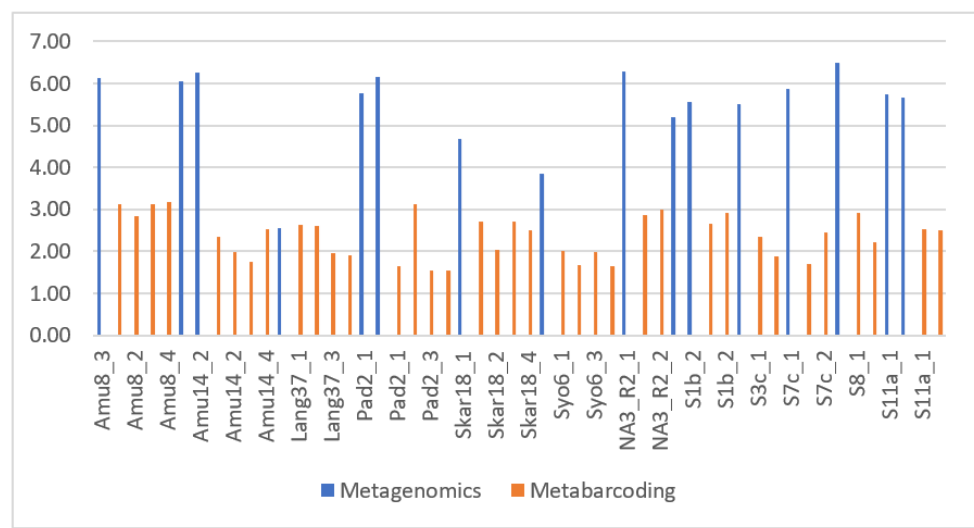
Figure 1. Shannon indices for all analyzed samples. Samples to the left—Amu8 to Syo6—are from East Antarctica, whereas samples to the right—NA3_R2 to S11a—are from Svalbard (the Arctic). The difference between the Shannon indices of the metagenomic and metabarcoding data sets was due to a higher number of OTUs recognized by the Kraken 2 software in the metagenomic datasets. Many OTUs could not be found at all in the metabarcoding data sets. Even after removal of the low abundant OTUs, 10 to 60% (depending on